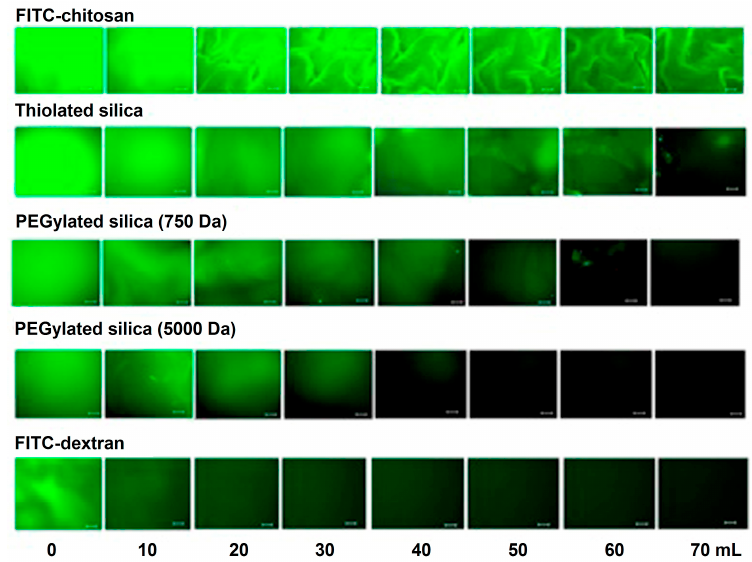
Figure 3. Representative microscopic fluorescence images of ex vivo porcine urinary bladder mucosa incubated with FITC-chitosan, thiolated silica, PEGylated silica (750 Da), PEGylated silica (5000 Da) and FITC-dextran and washed with different volumes of artificial urine solution. Scale bar = 200 µm. [37].